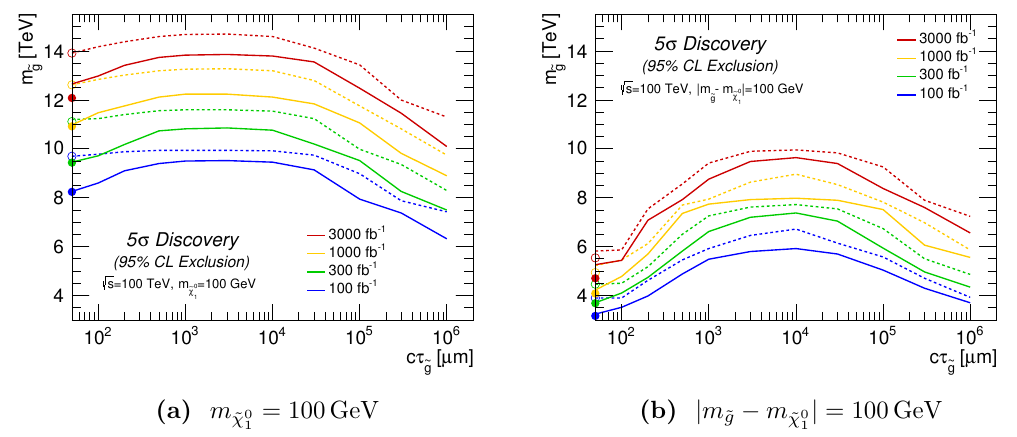
Figure 22. The expected 95% CL exclusion limits (dotted) and 5 (cid:27) discovery reaches (solid) as functions of c(cid:28) ~ g for di(cid:11)erent values of integrated luminosity at a future 100 TeV pp collider. The expected exclusion limit (discovery reach) for c(cid:28) ~ g = 0 is represented by a circle (a blob).